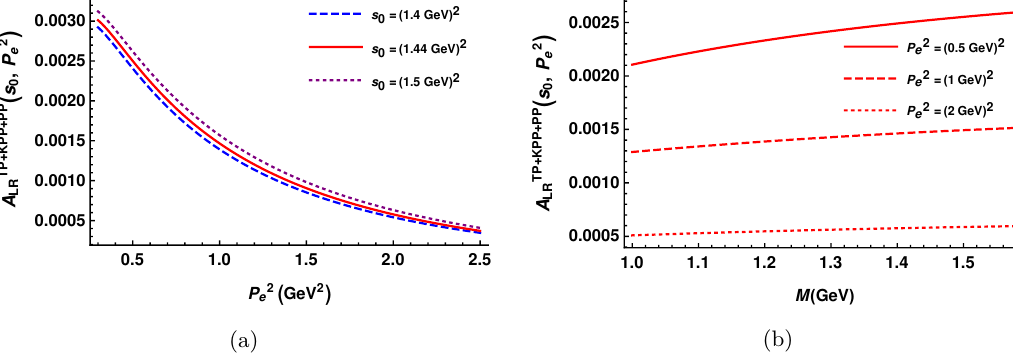
, F KPP and F PP LR LR LR